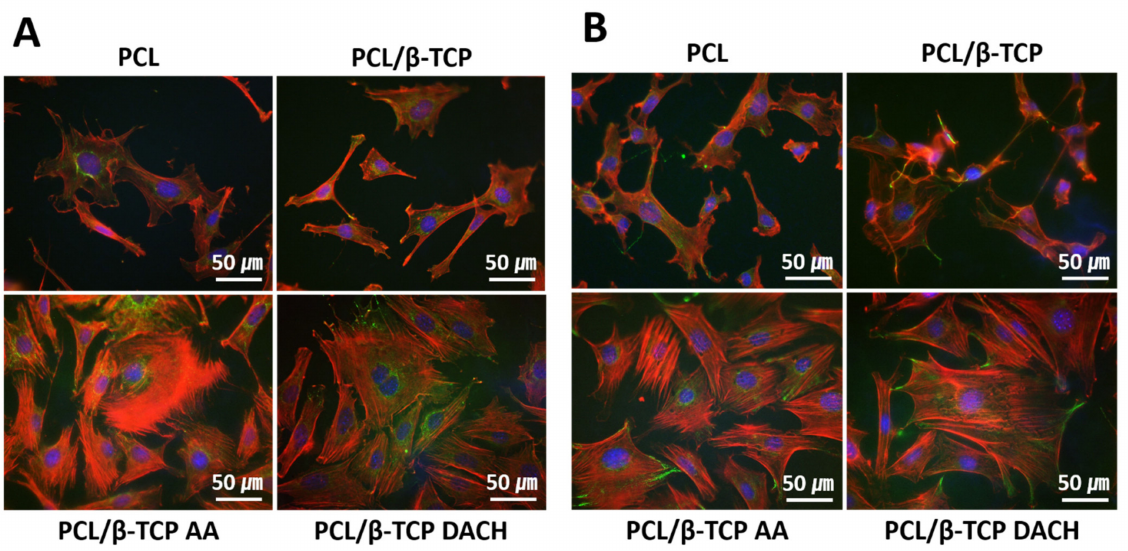
Figure 10. Fluorescence microscopy images of MC3T3-E1 cells adhered to each scaffold. After 5 h cell seeding, samples were fixed and processed for immunofluorescence using an Alexa-Fluor 488 fluorescent antibody to detect vinculin and paxillin (green), Rhodamine-phalloidin to label actin (red), and DAPI to label nucleic acids in the nucleus (blue). Each image is representative of both groups ( A ) vinculin and ( B ) paxillin (400 ×